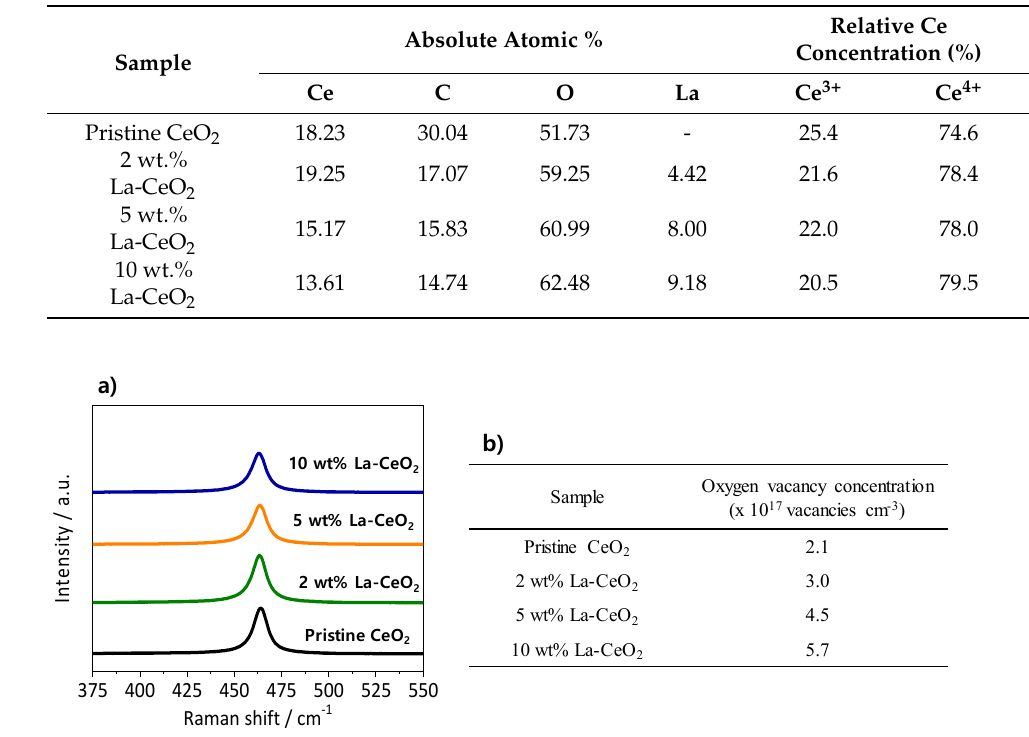
Figure 3. ( a ) Raman spectra of the pristine CeO 2 and the La-doped CeO 2 NPs. ( b ) Oxygen vacancy concentration on the samples estimated by the Raman spectroscopy.